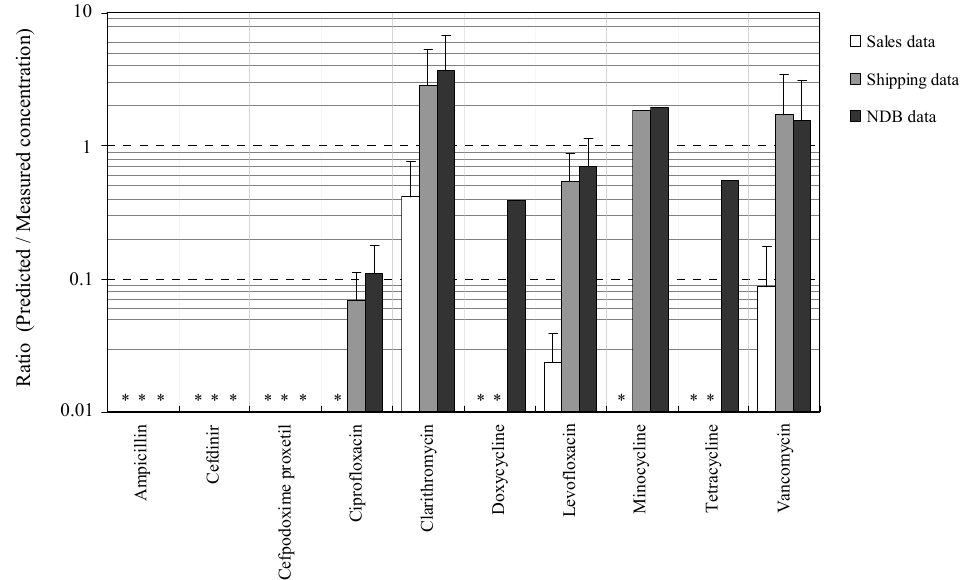
Figure 2. Correspondence ratios for predicted/measured concentration of target antimicrobials in STP influents (*: Not detected).